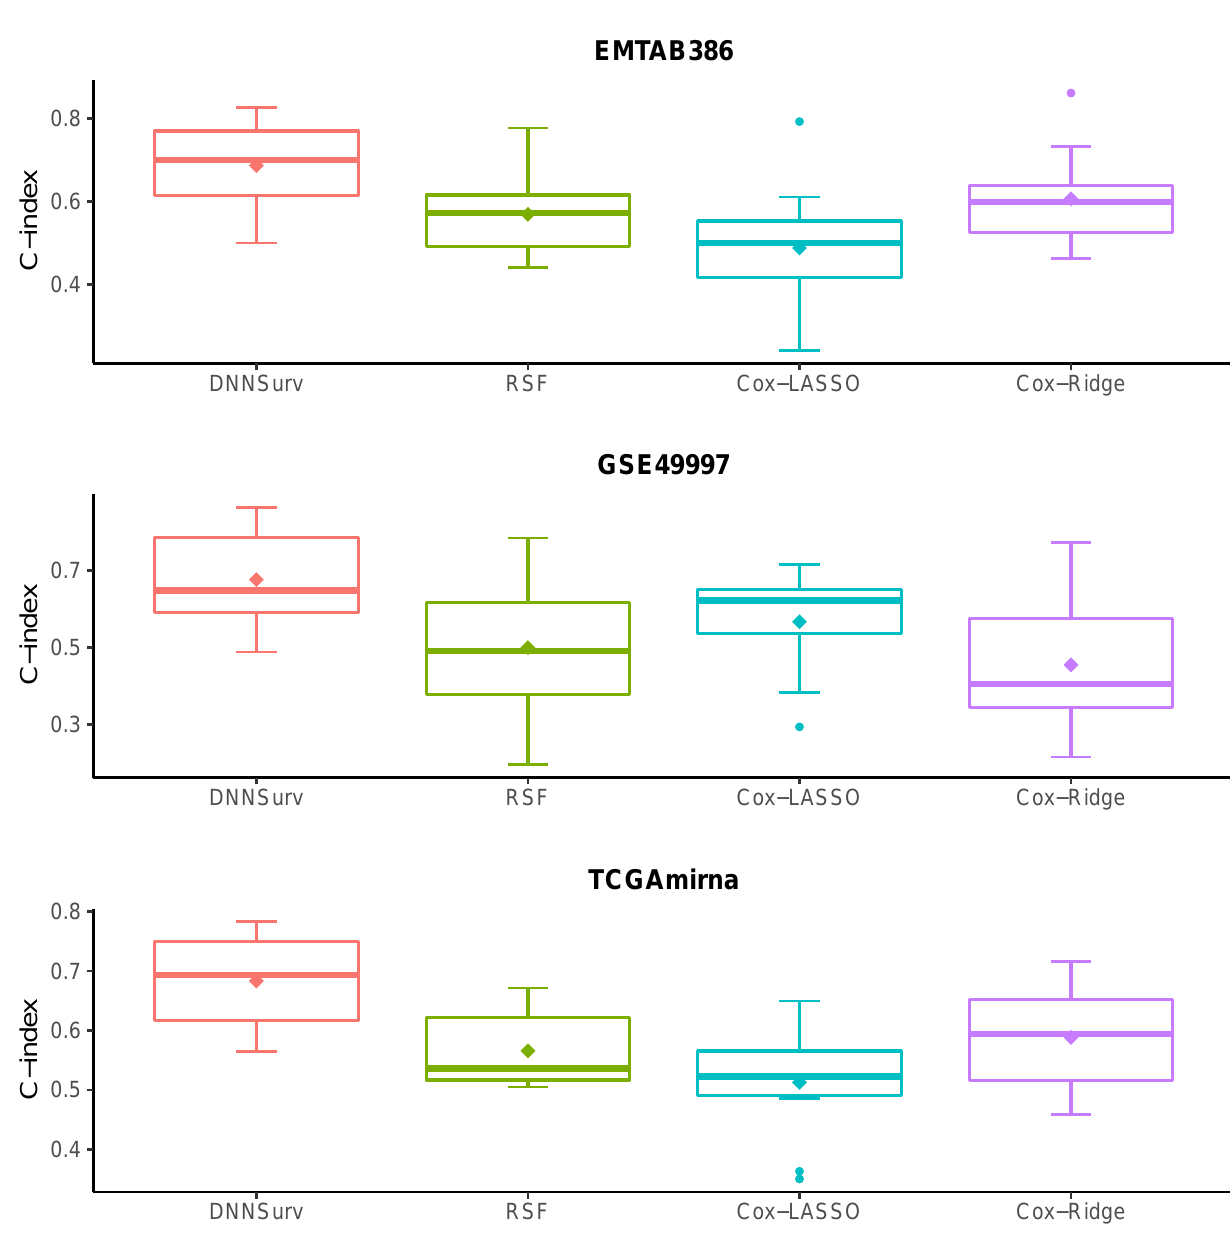
Figure 5. Boxplots of the C-index for four models on three test datasets that contain both gene and clinical variables (G +